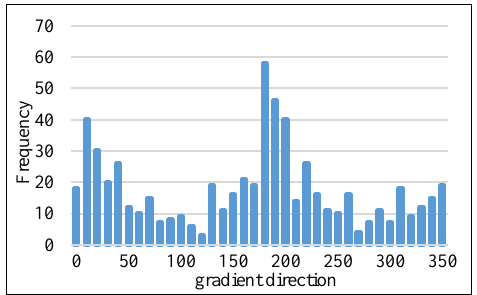
Figure 5. Histogram of gradient directions from blurry